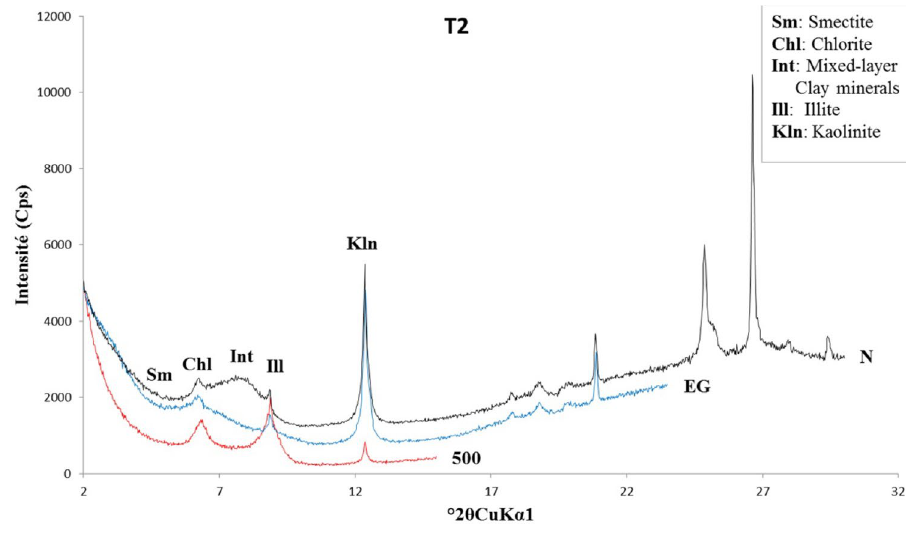
Fig. 6 X-ray diffraction pat- terns (N, EG, 500) for oriented preparations in < 2 µm clay fractions ( Sample: T3